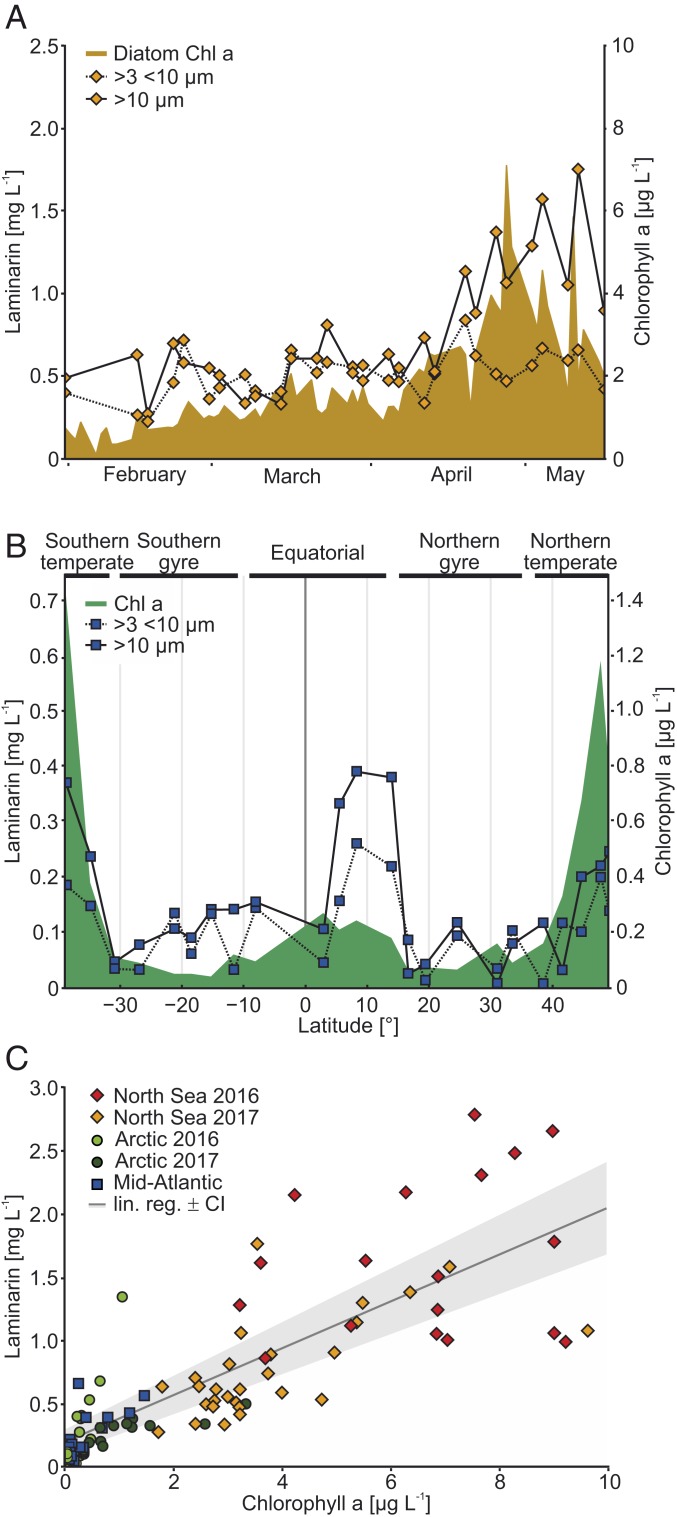
Laminarin and Chl-a concentrations correlate in a North Sea spring bloom time series, in the Atlantic, and in the Arctic. (A) Laminarin and Chl-a were determined in different size fractions during a phytoplankton spring bloom in the North Sea in 2017. (B) Laminarin was measured in different size fractions along a meridional transect from the North to the South Atlantic. (C) Comparison of laminarin and chlorophyll concentrations in all datasets where Chl-a was measured. Linear regression was applied to the laminarin-to-Chl-a relationship (R2 = 0.66; P < 0.001, n = 101). The confidence interval (CI) in gray was calculated at level 0.95.